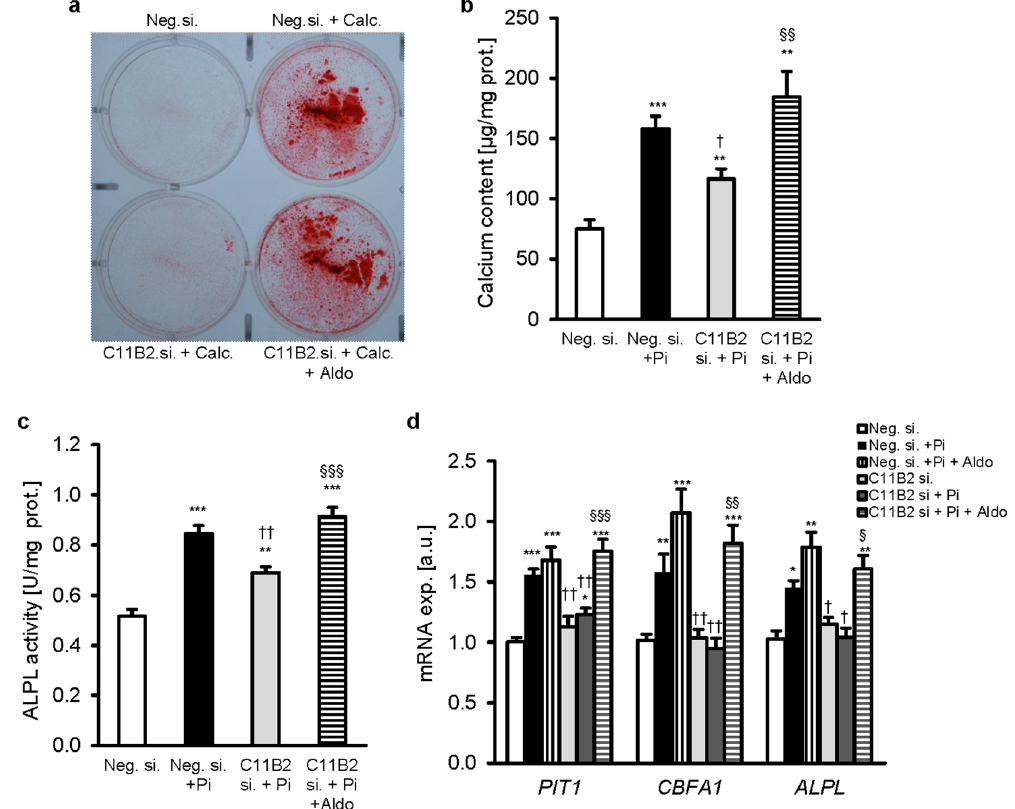
Figure 3. Aldosterone synthase inhibition reduces phosphate-induced vascular calcification in vitro . ( a ) Representative original images showing Alizarin red staining in HAoSMCs silenced with negative control siRNA (Neg.si.) or CYP11B2 siRNA (C11B2si.) and treated with or without calcification medium and with or without additional treatment with 100 nM aldosterone (Aldo). Images are representative for four independent experiments. The calcified areas are shown as red staining. Arithmetic means ± SEM of calcium content ( b , n = 12; µ g/mg protein), alkaline phosphatase activity ( c , n = 8; units/mg protein) and of PIT1 , CBFA1 and ALPL relative mRNA expression ( d , n = 14, arbitrary units, a.u.) in HAoSMCs silenced with Neg.si. or C11B2si. and treated with (Pi) or without (Ctr) phosphate and with or without additional treatment with 100 nM aldosterone (Aldo). * (p < 0.05), ** (p < 0.01), *** (p < 0.001) statistically significant vs. Neg.si. silenced HAoSMCs. † (p < 0.05), †† (p < 0.01) statistically significant vs. Pi treated Neg.si. silenced HAoSMCs. § (p < 0.05), §§ (p < 0.01), §§§ (p < 0.001) statistically significant between Pi and Pi + Aldo treated C11B2si silenced